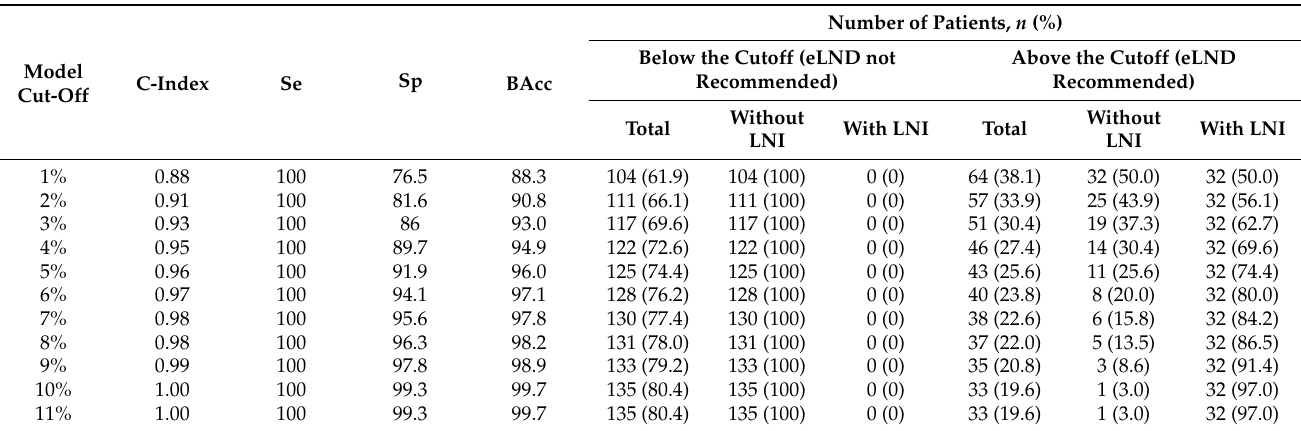
Table 3. Results of the New-Combined model by cut-offs in the training